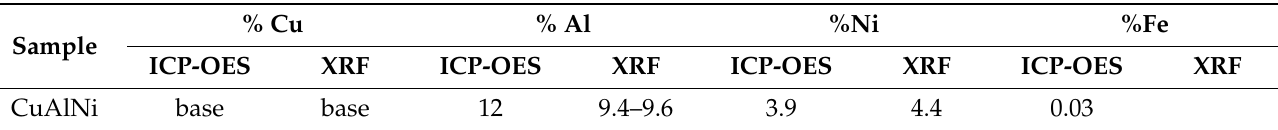
Table 1. Percentage composition of the studied CuAlNi alloy.